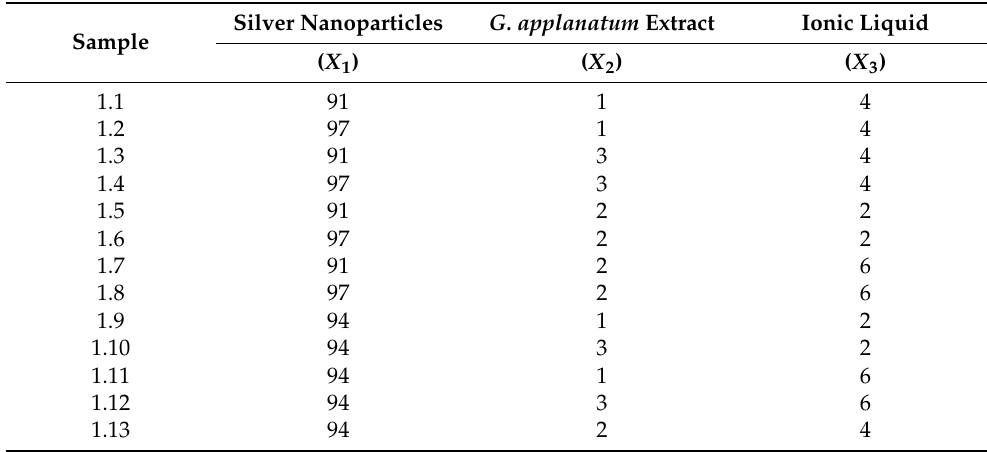
Table 1. Ratio optimization of silver nanoparticles ( X 1 ), G. applanatum extract ( X 2 ), and ionic liquid ( X 3 ) by the Design-Expert ® program (Stat-Ease, Inc.).